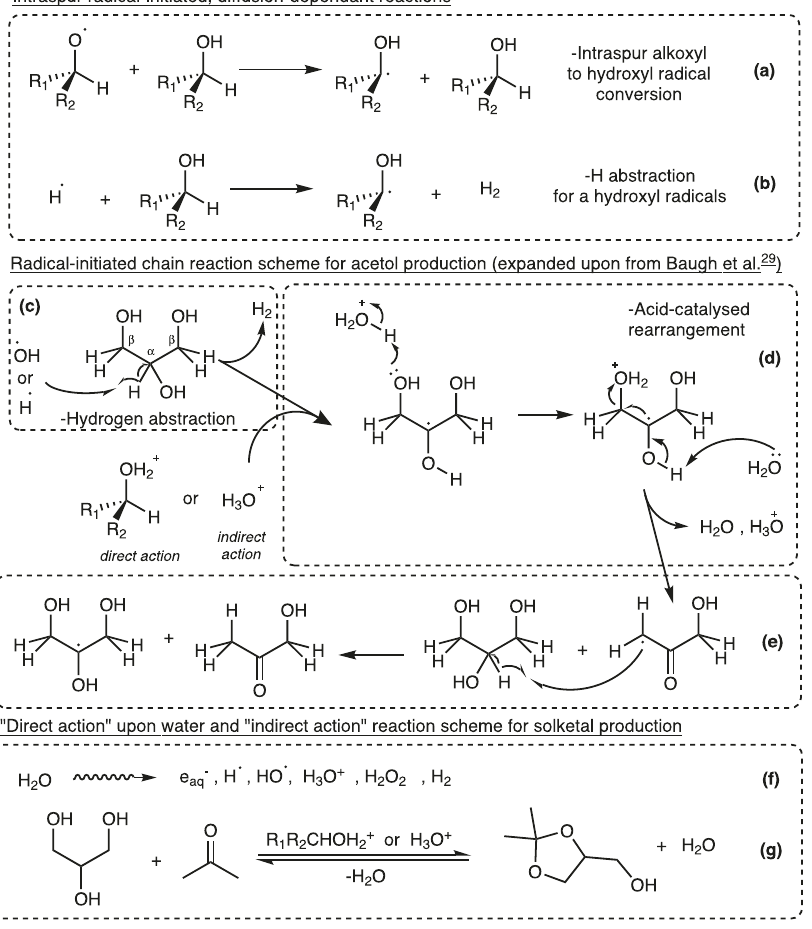
Fig. 4 Subsequent radiation-directed, diffusion-controlled reactions. Radical-directed reactions ( a – c ): ( a ) Intraspur radical conversion to the more stable hydroxy radical. b C – H scission dominated by α -hydrogen abstraction. Reactions ( c – e ) is the expanded mechanism for acetol production 29 . c Hydrogen abstraction at the weaker α -C – H bond. d Acid-catalyzed chain rearrangement via an acidi fi ed species. e α -H-abstraction and α -hydroxy radical regeneration. f Direct action on water producing reactive species such as H 3 O + . g Acid-catalyzed chemical ketalization reaction scheme for solketal (R 1 and R 2 = – CH 2 OH for α -carbon or H and – CHOH-CH 2 OH for β -carbon radicals,